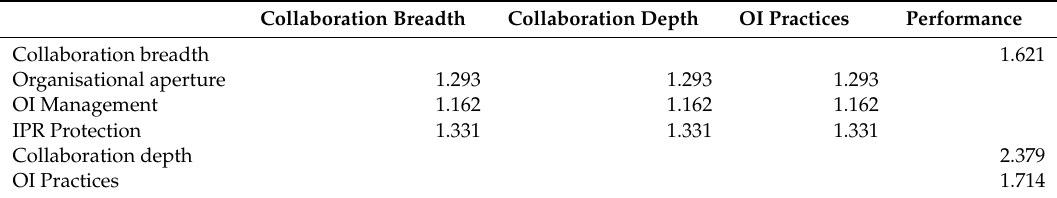
Table 12. VIF values of structural model